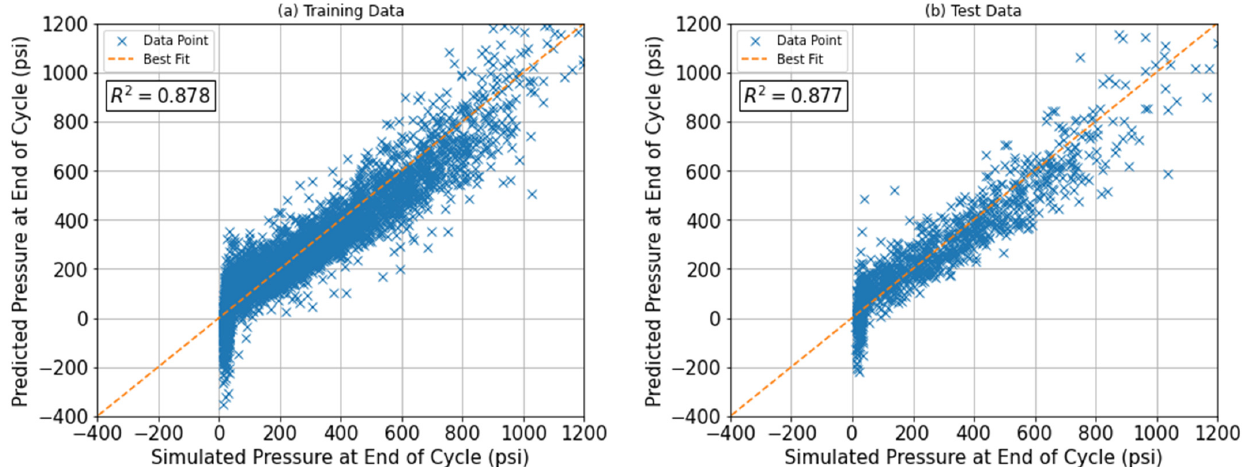
Figure 11. Predicted and simulated plot of ( a ) training data and ( b ) testing data for reservoir pressure at the end of the cycle—polynomial regression model.